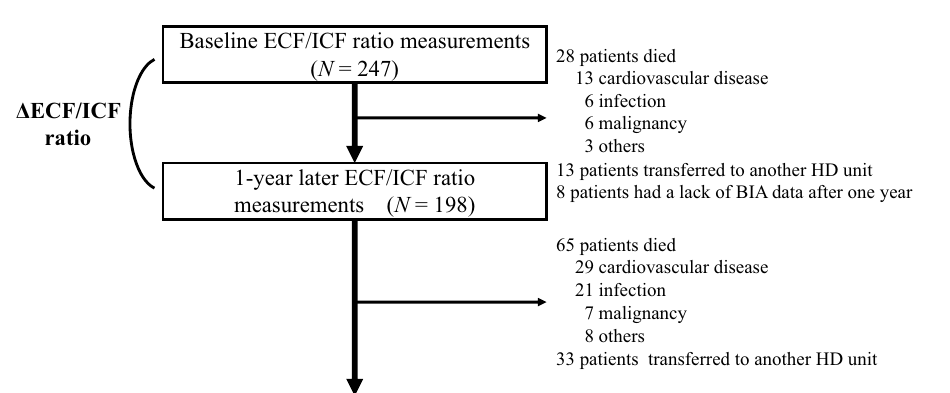
Figure 1. Flow diagram of the present study. ECF/ICF ratio, extracellular fluid/intracellular fluid ratio; HD, hemodialysis.